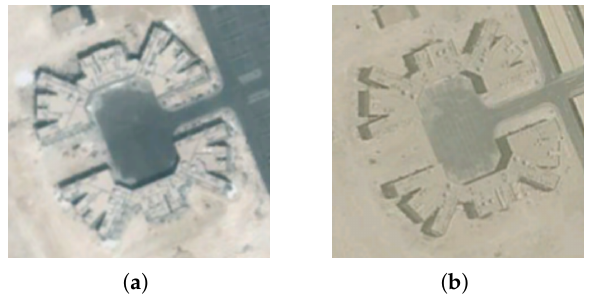
Figure 1. Image pair obtained from different viewpoints. ( a ) The image of phase one. ( b ) The image of phase